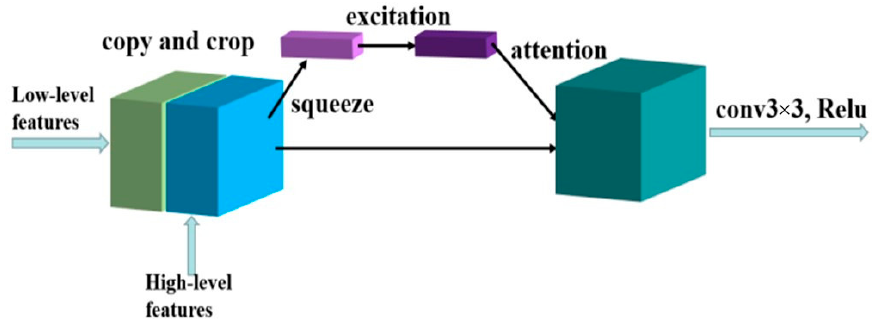
Figure 14. The framework of the squeeze and excitation block. The squeeze part means that all the eigenvalues in each channel are summed up and averaged, namely global average pooling, which is defined in Formula (8)